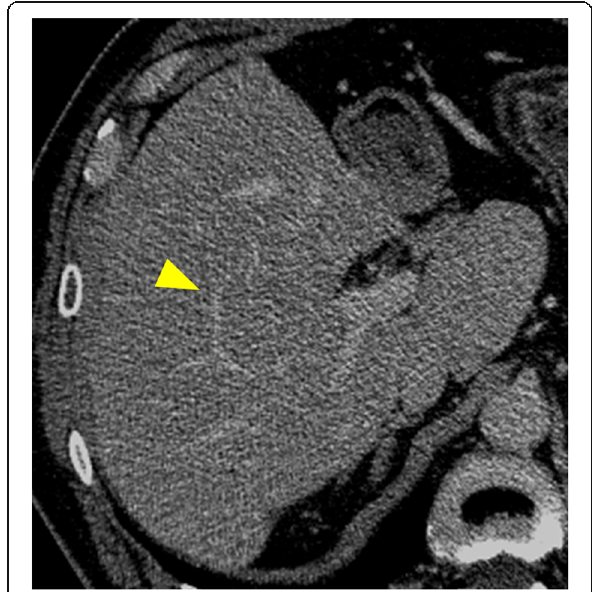
Fig. 5 Contrast-enhanced CT performed 10 months after the second hepatectomy. Intrahepatic venous collaterals ( yellow arrowhead ) between the RHV and MHV remained